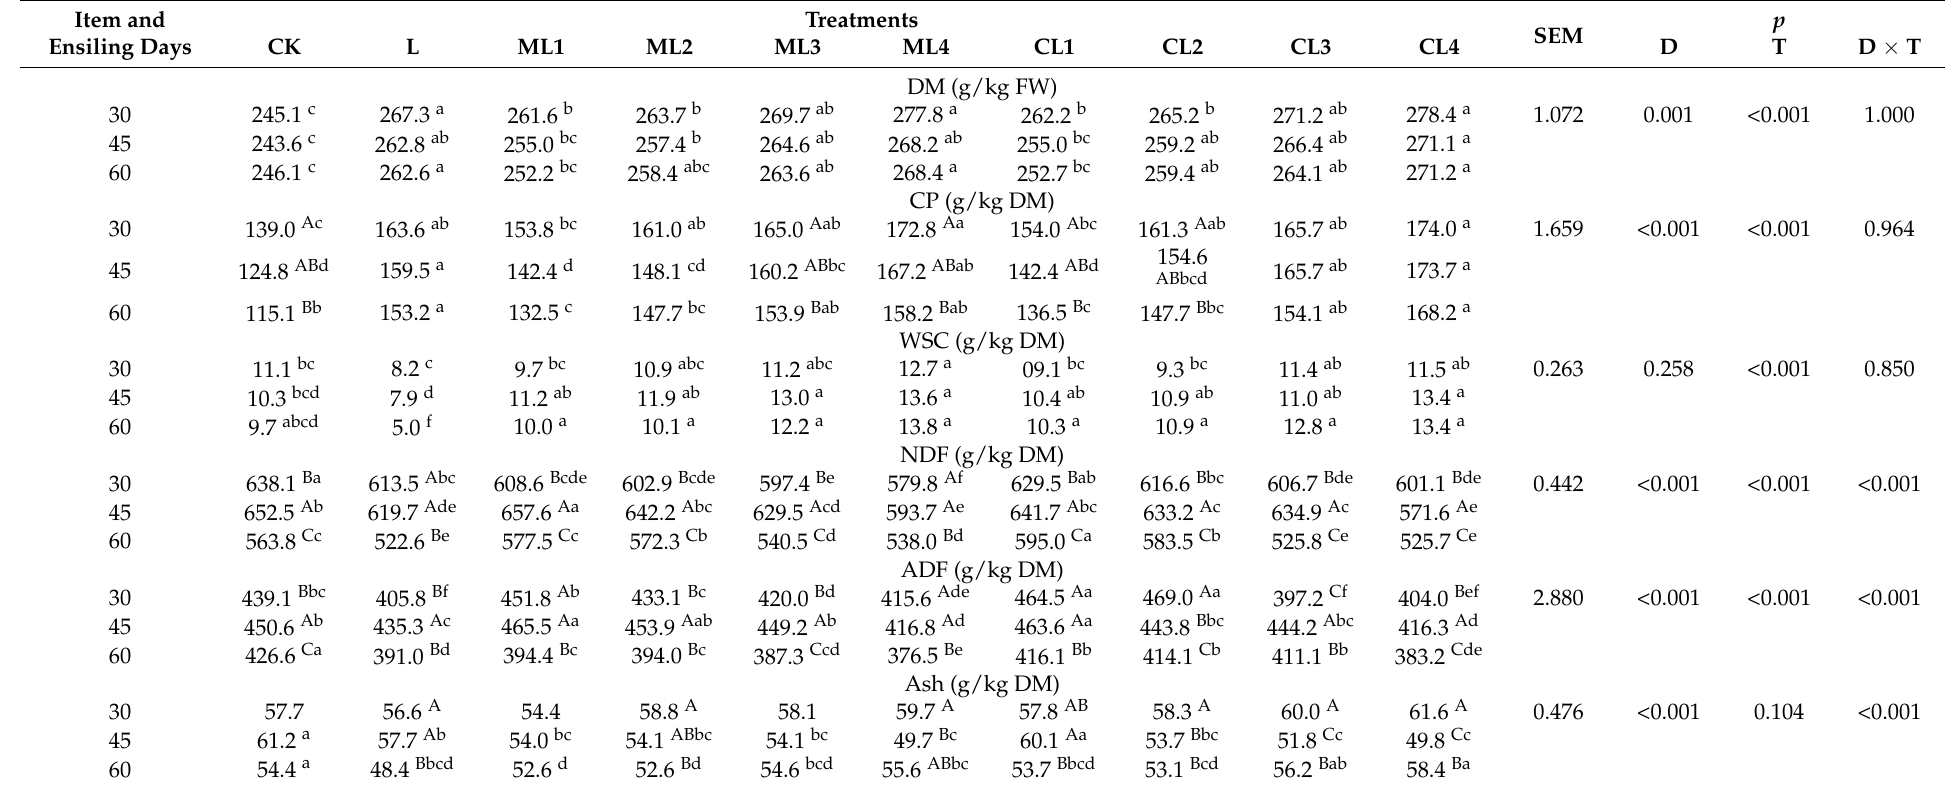
Table 2. Effect of ensiling time and additives on nutritional components of Chamaecrista rotundifolia